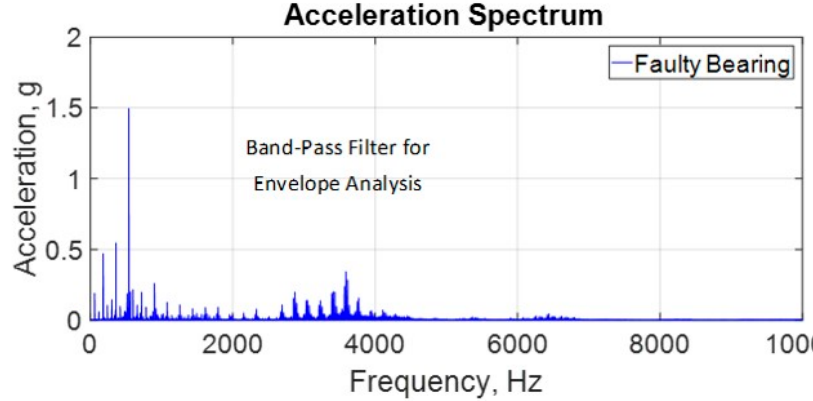
Figure 3. Acceleration spectrum for the faulty bearing.